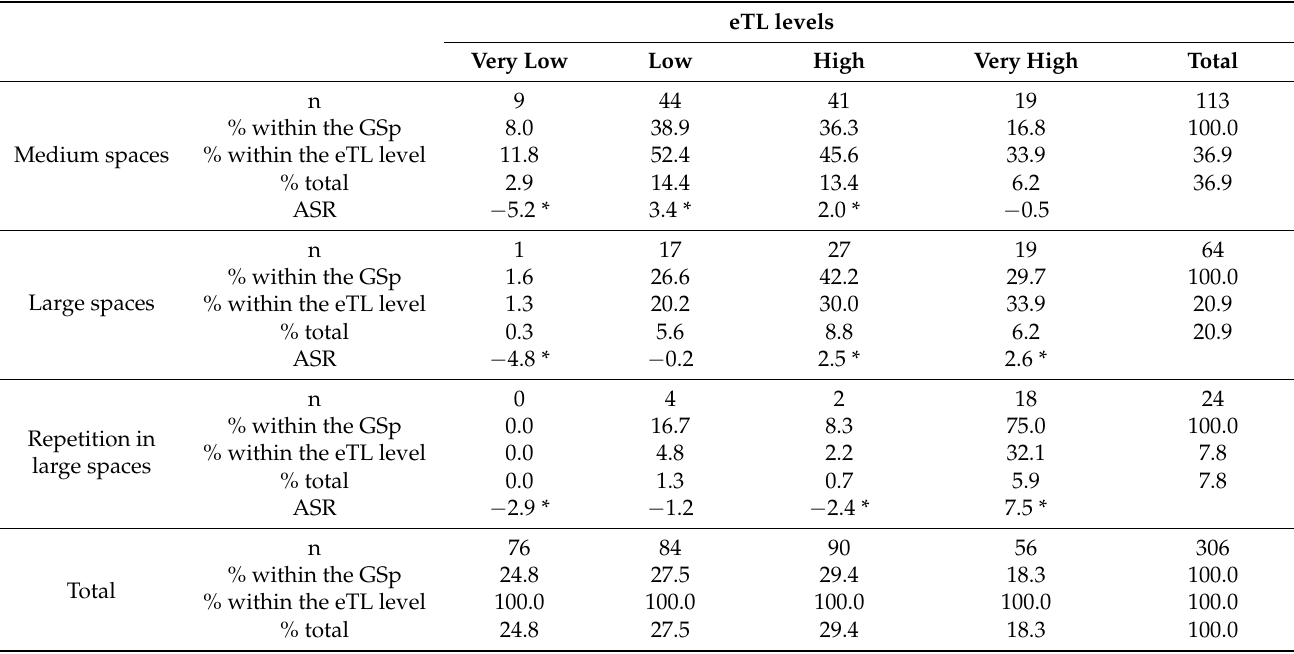
Table 4. Pairwise comparisons (for the eTL) of the game situation categories.